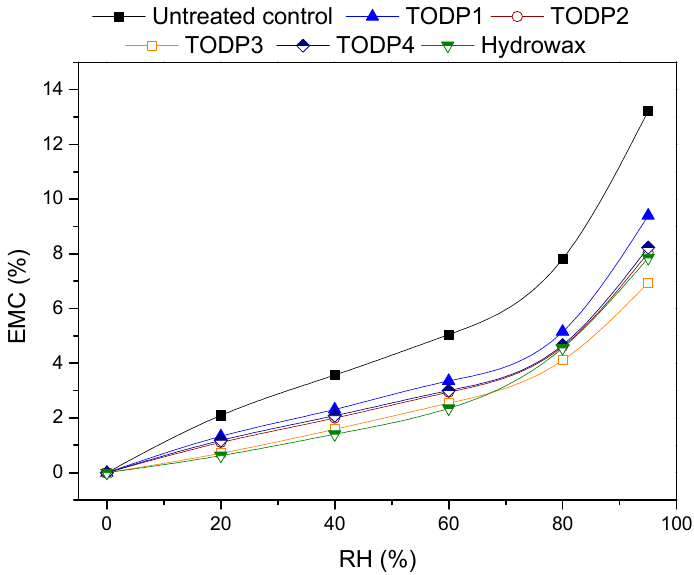
Figure 2. Equilibrium moisture content (EMC) of paper samples treated with hydrowax and with TODP1-, TODP2-, TODP3- and TODP4-based formulations during the adsorption process.